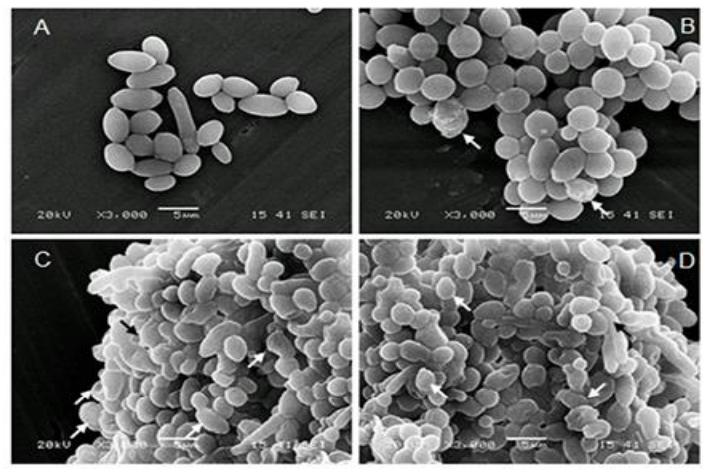
Figure 3. Scanning electron microscopy micrographs of C. albicans following treatment with Mentha piperita EO . (A) Untreated Candida ; ( B ) treated with the vapor of 10 µ L/mL of EO; ( C ) treated with × piperita EO . (A) Untreated Candida ; (B) treated with the vapor of 10 μ L/mL of EO; (C) treated with 10 µ L/mL of EO added to the culture medium; or ( D ) treated with AmB for 24 h then subjected to 10 μ L/mL of EO added to the culture medium; or (D) treated with AmB for 24 h then subjected to scanning electron microscopy (SEM) analyses. Each experiment was repeated three times. Note the cell size and cell shape changes following contact with the EO, which was comparable to that observed with AmB.